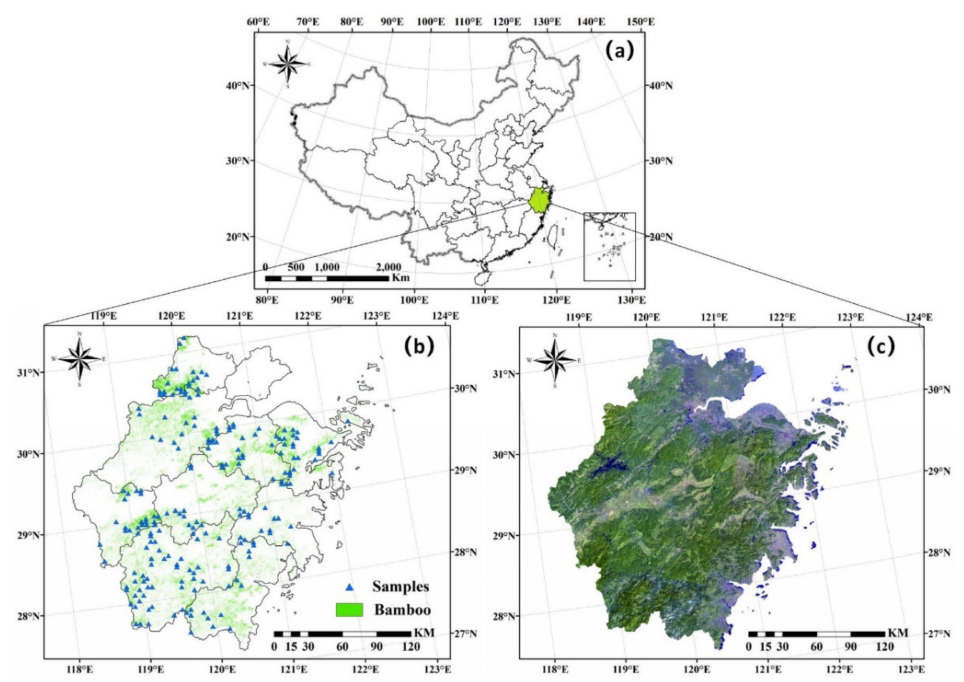
Figure 1. ( a ) Location of the study area; ( b ) distribution and biomass of bamboo forests in Zhejiang Province in 2014; ( c ) 2014 Landsat 8 false-color synthesis image of Zhejiang